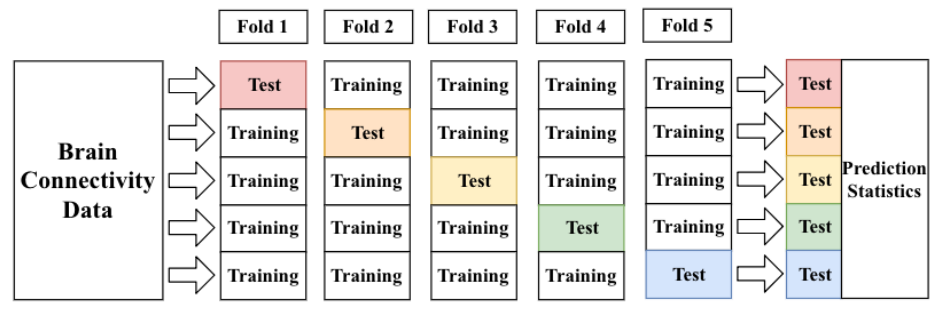
Figure 2. The five-fold cross-validation method for analyzing brain connectivity